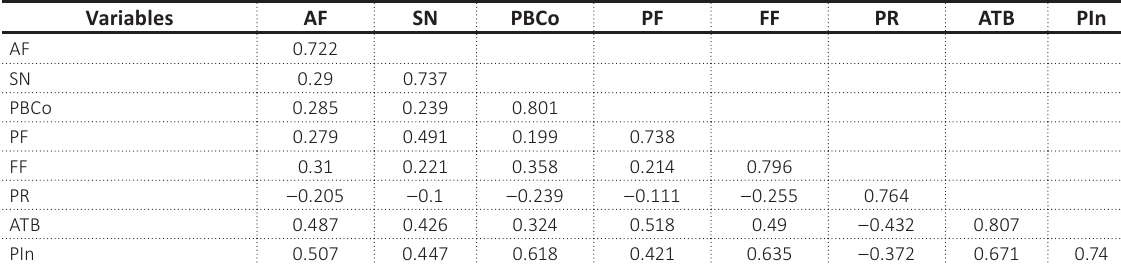
Table 3. Correlation between the